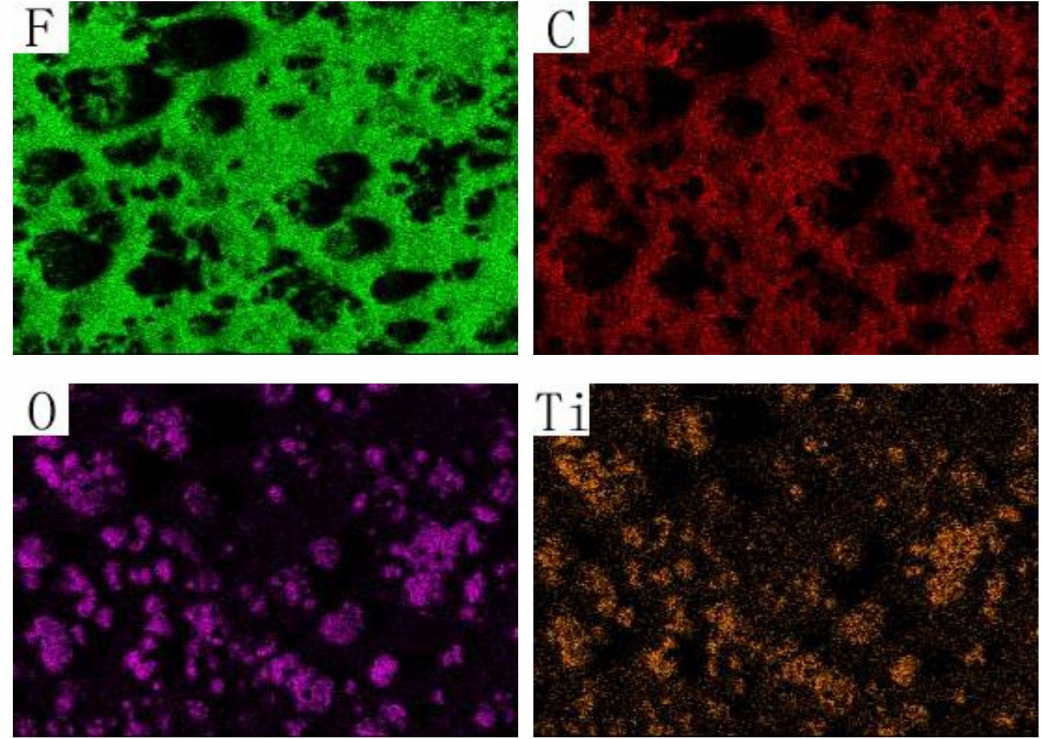
Figure 3. Energy-dispersive X-ray spectroscopy (EDS) elemental maps of PEO–PTFE composite